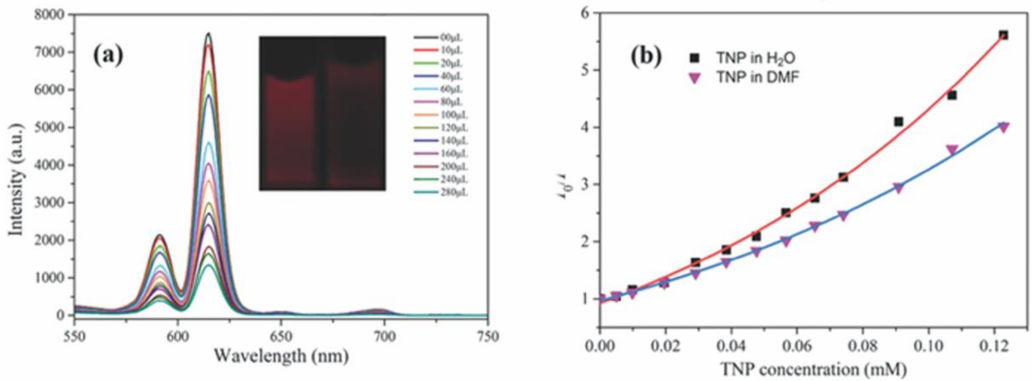
Figure 8. ( a ) Effect on the emission spectra of the activated EuMOF dispersed in H 2 O upon incremental addition of a 2,4,6-trinitrophenol (TNP) aqueous solution (1 mM) ( λ ex = 362 nm). The legend indicates the overall concentration of TNP. Inset: A photograph showing the original fluorescence ( left ) and the fluorescence quenching ( right ) upon the addition of 280 µ L TNP (UV light, 365 nm). ( b ) Stern–Volmer plots of I 0 / I versus the TNP concentration in DMF and water. Reproduced with permission from [107]. Copyright 2014